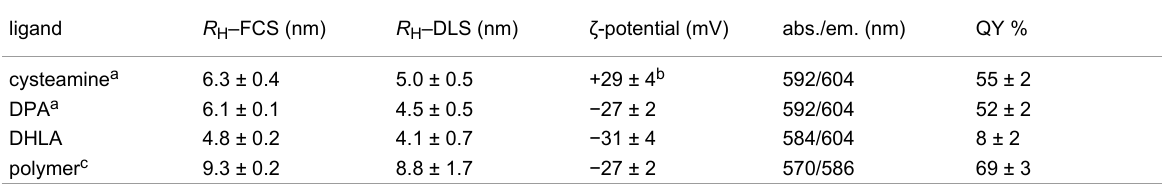
Table 1: Characterization of the CdSe/ZnS QDs, suspended in PBS, pH 7.4. ligand